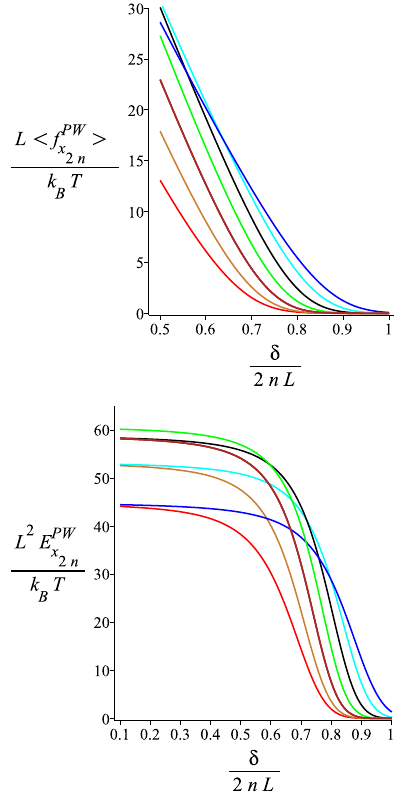
Figure 18. The first panel : The dimensionless force of the structure with an even number of arms exerted on the confining wall as a function of the dimensionless distance of the wall from the grafting point. The second panel : The dimensionless differential stiffness of the system with an even number of arms as a function of the dimensionless distance of the wall from the grafting point. The red, gold, brown, green, black, cyan, and blue are associated with the fixed values of the external field + π i , where i = 0,1,2,3,4,5,6, respectively. The other fixed orientation parameter, φ B = − ω − π 2 6 = 30, n = 1, and K = parameters are: ω = π , φ µ = 0, l p B L 4